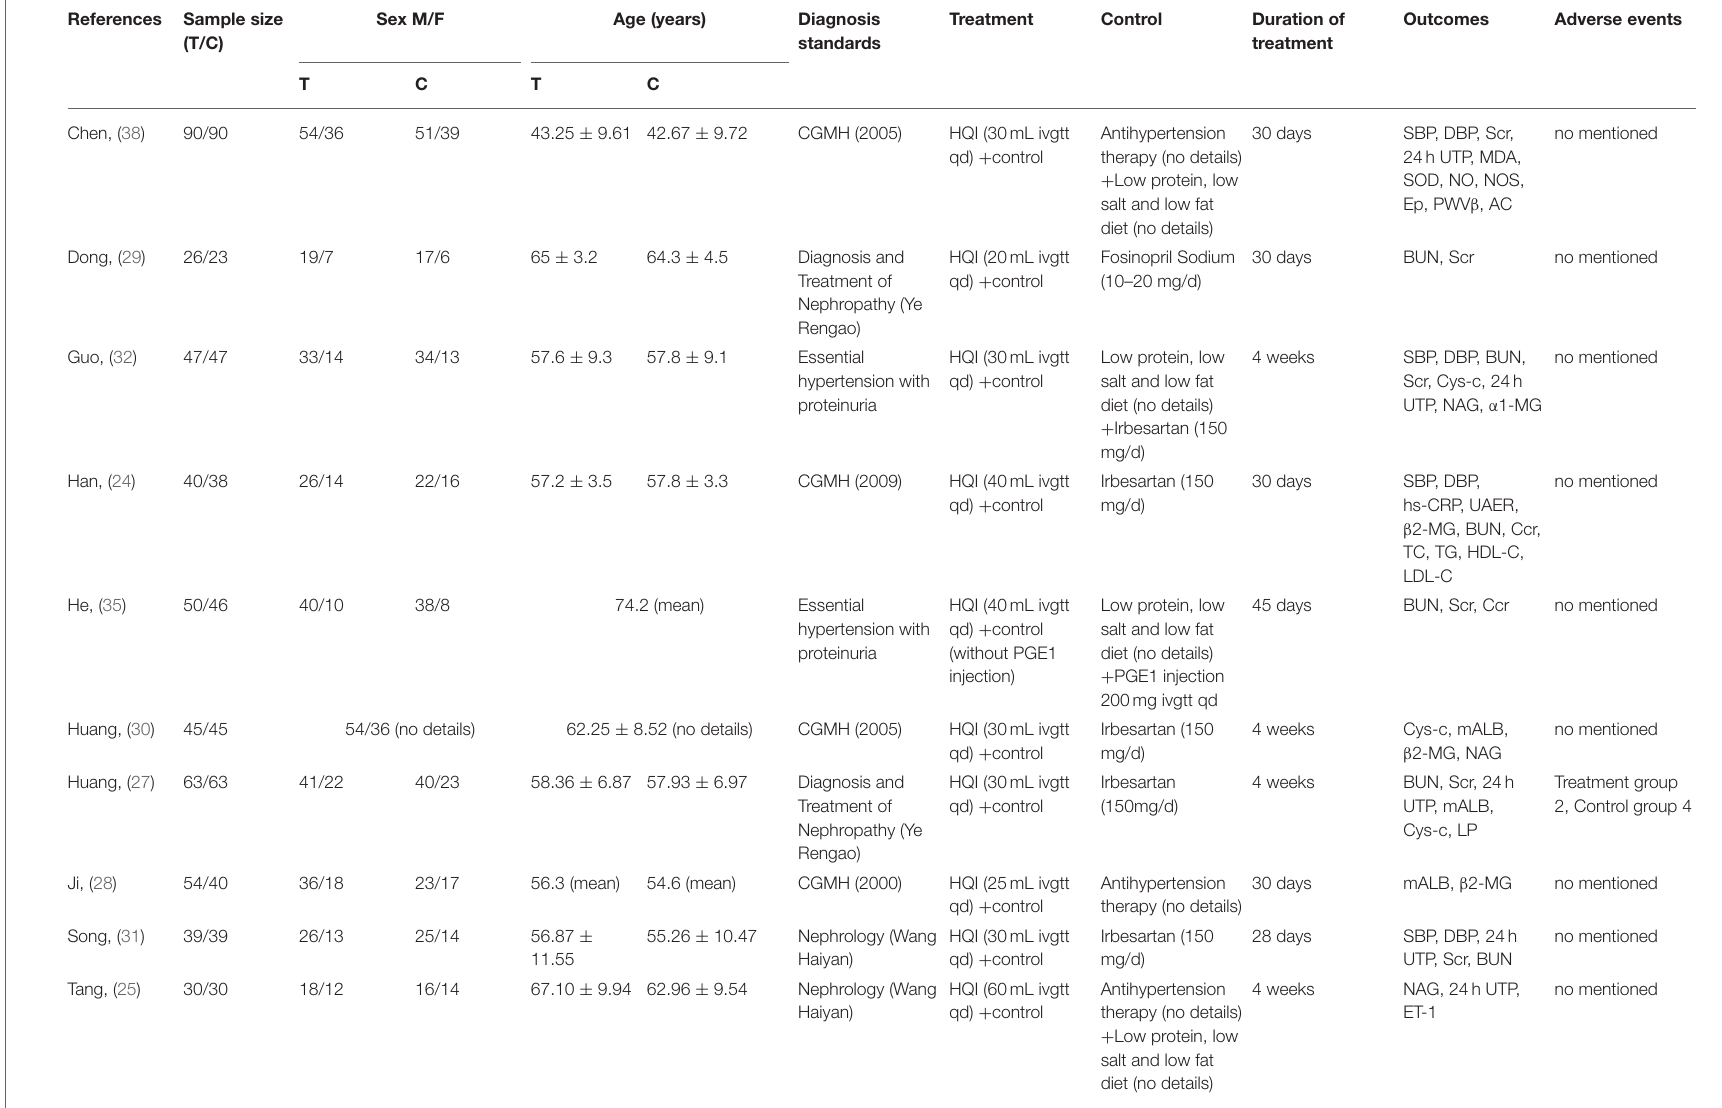
TABLE 1 | Characteristics of the included